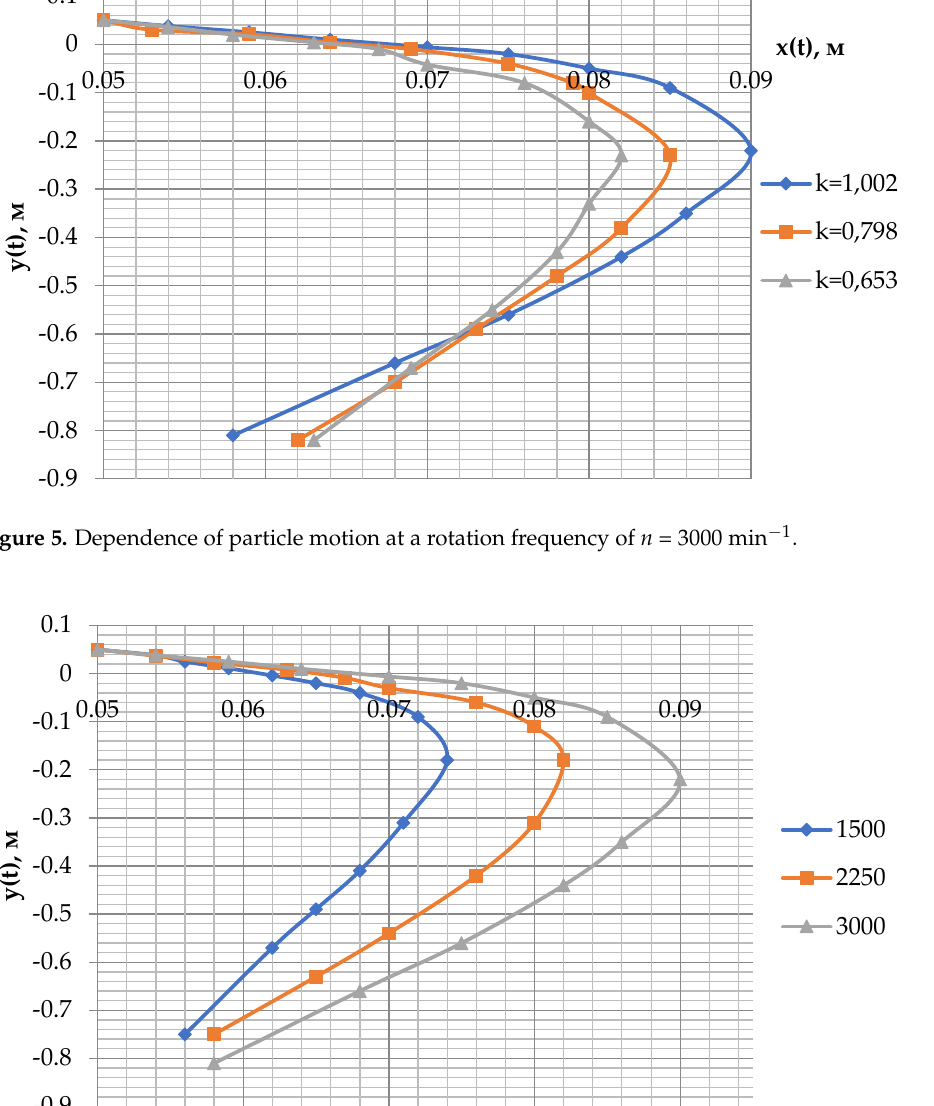
Figure 4. Dependence of the particle motion at a rotation frequency of n = 2250 min − 1 .